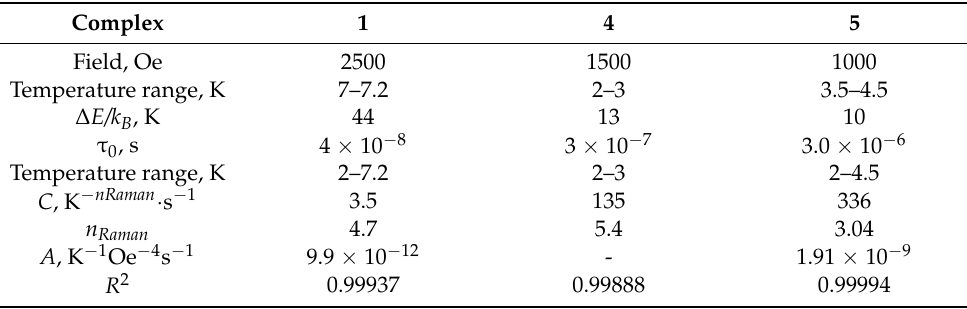
the correlation